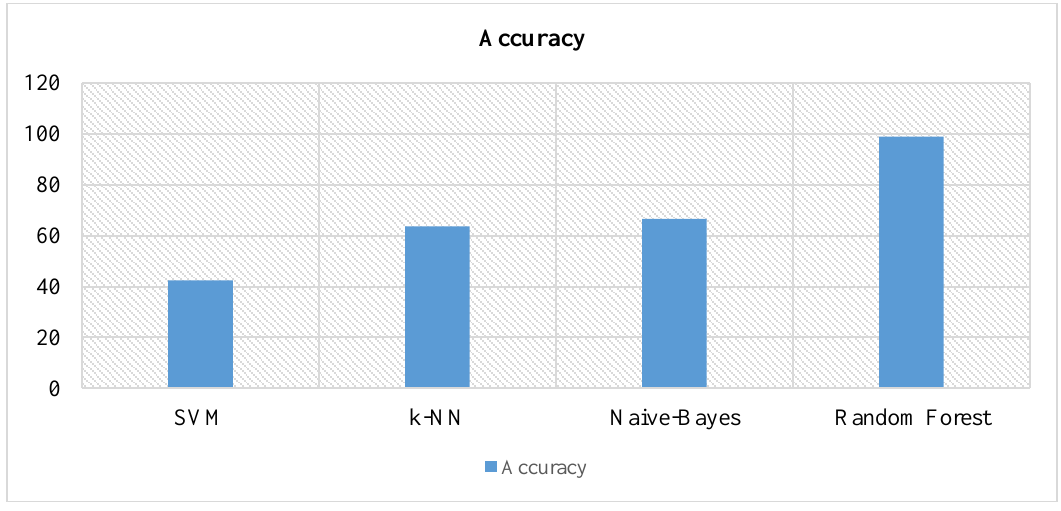
Figure 7. Comparison of various machine learning algorithms